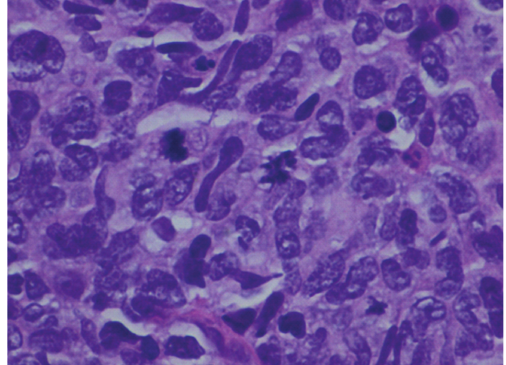
Figure 2: Sheets of large neoplastic lymphoid cells with some cells showing atypical mitoses. Thick capillary vessels and a few eosinophils can also be seen. (H&E 60x).